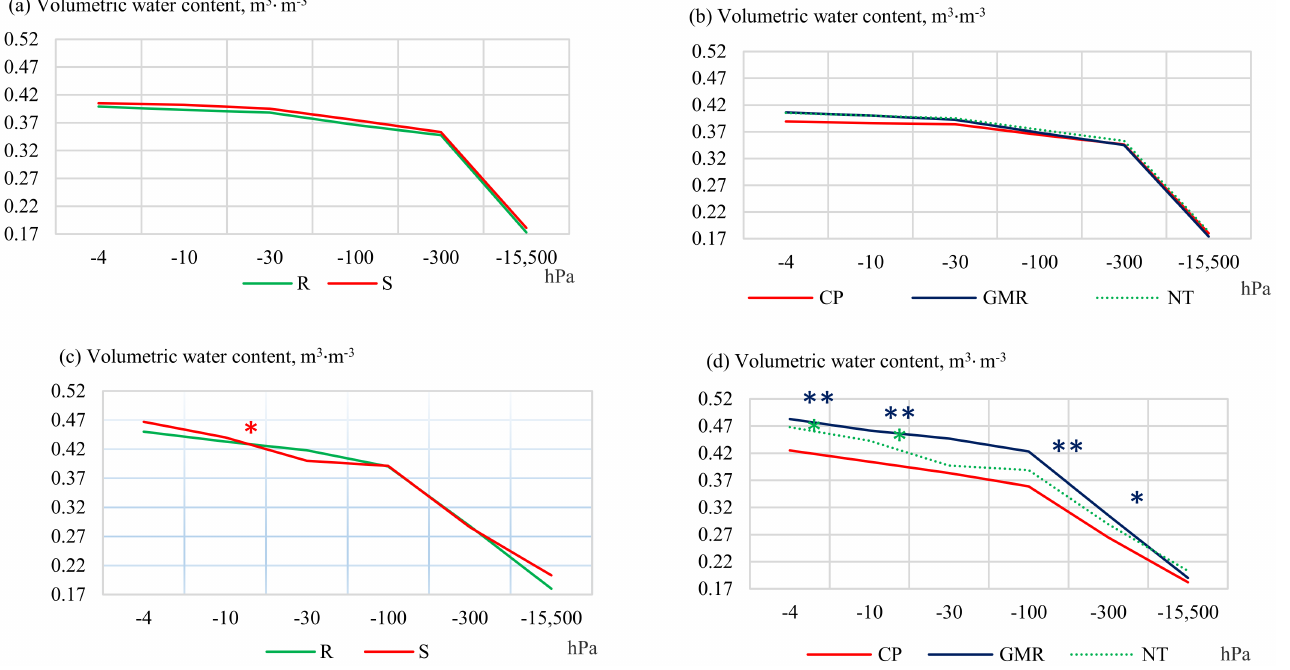
Figure 2. Soil water retention capacity at a depth of 5–10 cm in a ( a , b ) 2013 and ( c , d ) 2019. Notes: Significant differences at * p ≤ 0.05 > 0.01; ** p ≤ 0.01 > 0.001; Fisher LSD test vs. control. Other